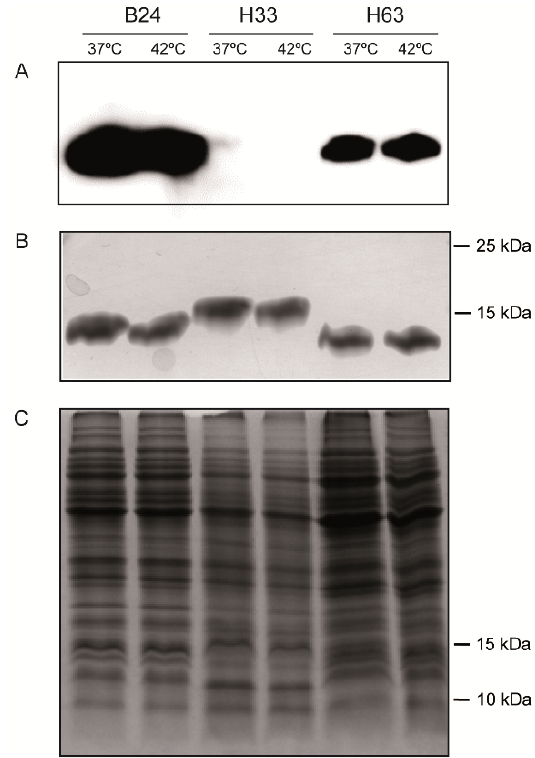
Figure 3. Analysis of LOS from C. jejuni strains grown at either 37 ◦ C or 42 ◦ C. ( A ). Detection of LOS SIAL in purified LOS samples from cultures of the indicated strains grown onto CBA plates for 48 h at either 37 ◦ C or 42 ◦ C. LOS SIAL was detected by Western blot using HRP-CT. ( B ). Silver-stained 15% SDS-PAGE of the same samples of purified LOS as in ( A ). ( C ). Coomassie-stained 15% SDS-PAGE of whole cell extracts from the cultures used to obtain the purified LOS samples analyzed in ( A , B ). In ( B , C ), the migration of the 10 and 15 kDa proteins from the molecular mass marker is indicated.